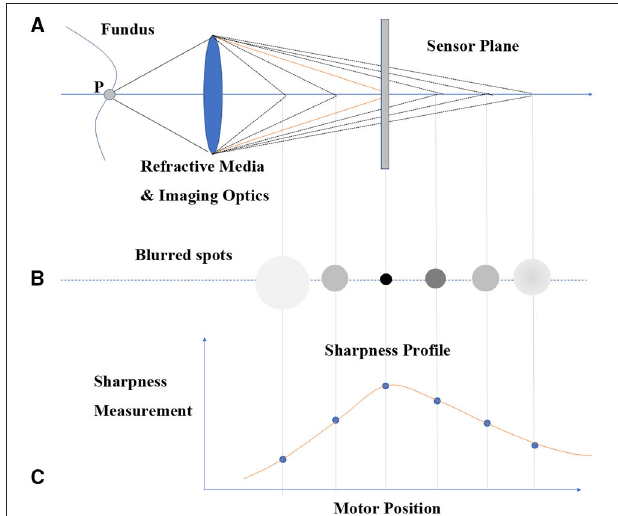
FIGURE 1 | MRT principle diagram. (A) Light ray radiation and sensor system. (B) Blurred image point with the change of focal length of fundus camera. (C) The sharpness profile of changing focal